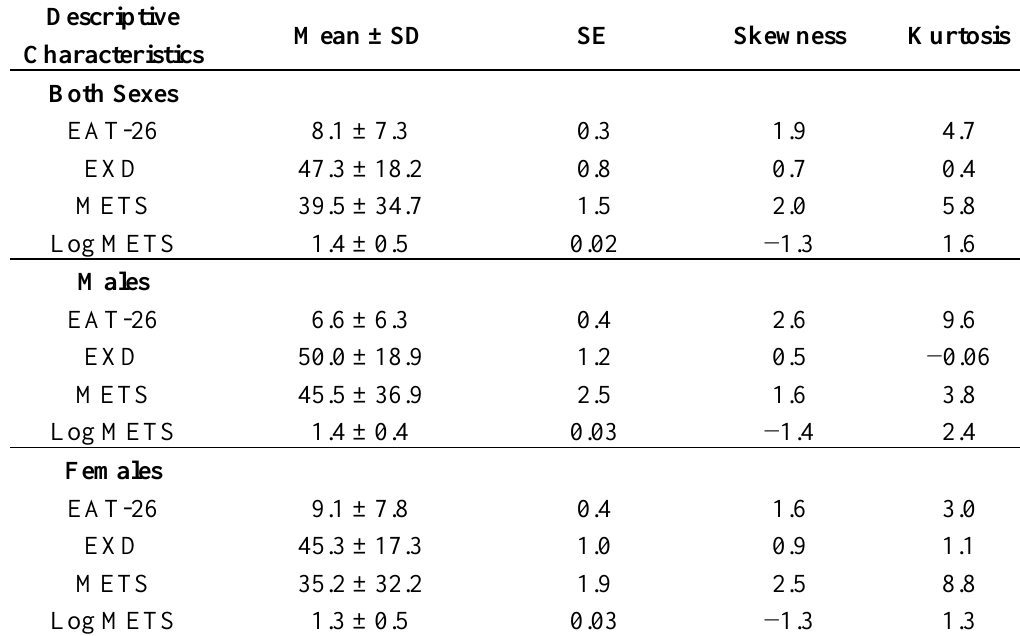
Table 2. Descriptive characteristics for EAT-26, EXD, METS and